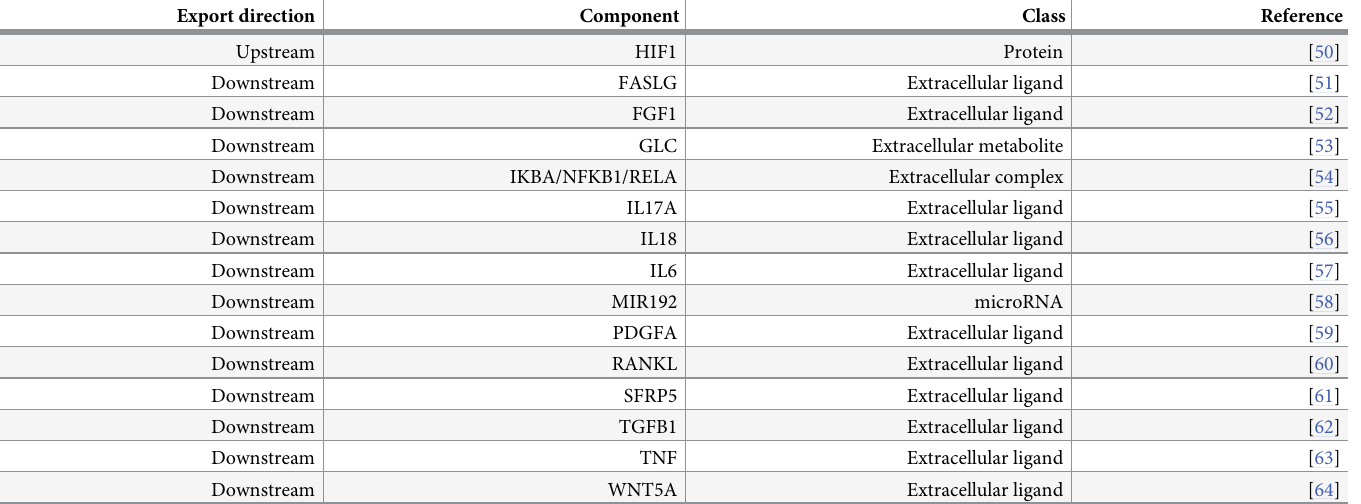
Table 1. RASF-specific components and the export direction used to infer a Boolean model from the RA-map V2 using